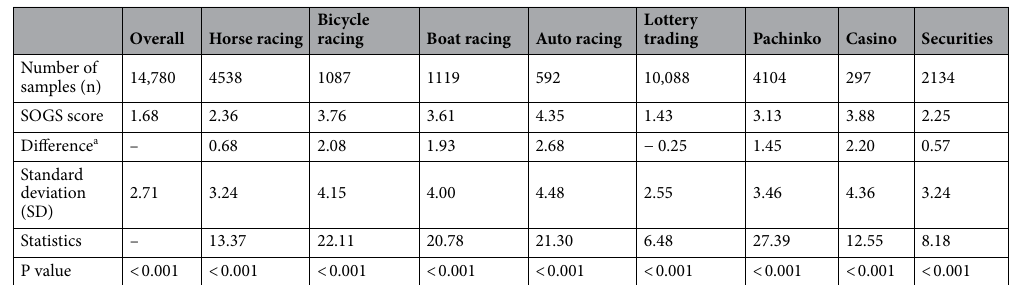
Overall Horse racing